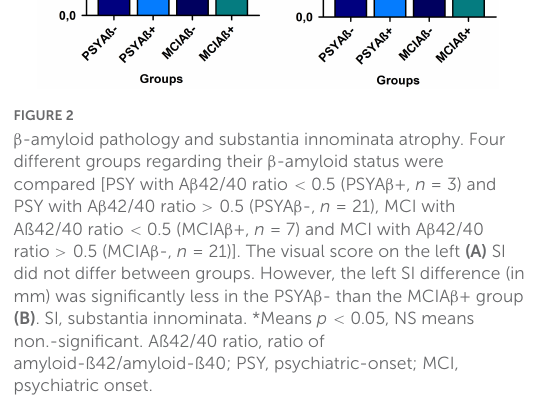
A β -, PSYA β - vs. MCIA β -, PSYA β + vs. MCIA β +, PSYA β -vs. MCIA β +, PSYA β + vs. MCIA β -) (data not shown). However, the left SI difference (in mm) was significantly less in the PSYA β - than the MCIA β + group ( Figure 2B ).